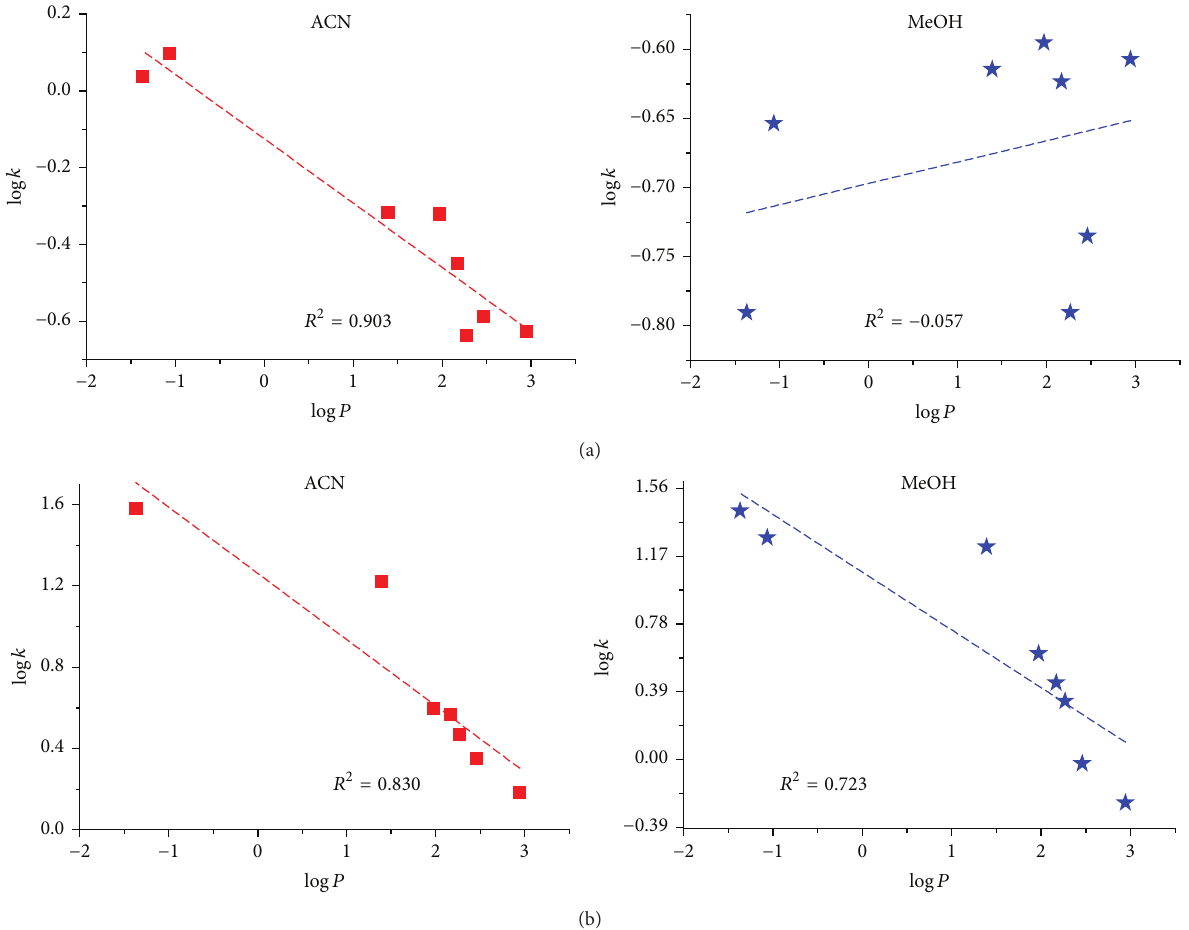
Figure 3: The relationship between log 𝑘 of flavonoids and log 𝑃 . Mobile phase: 95% ACN/ammonium formate or 95% MeOH/ammonium formate. (a) Bare silica column; (b) ZIC column.